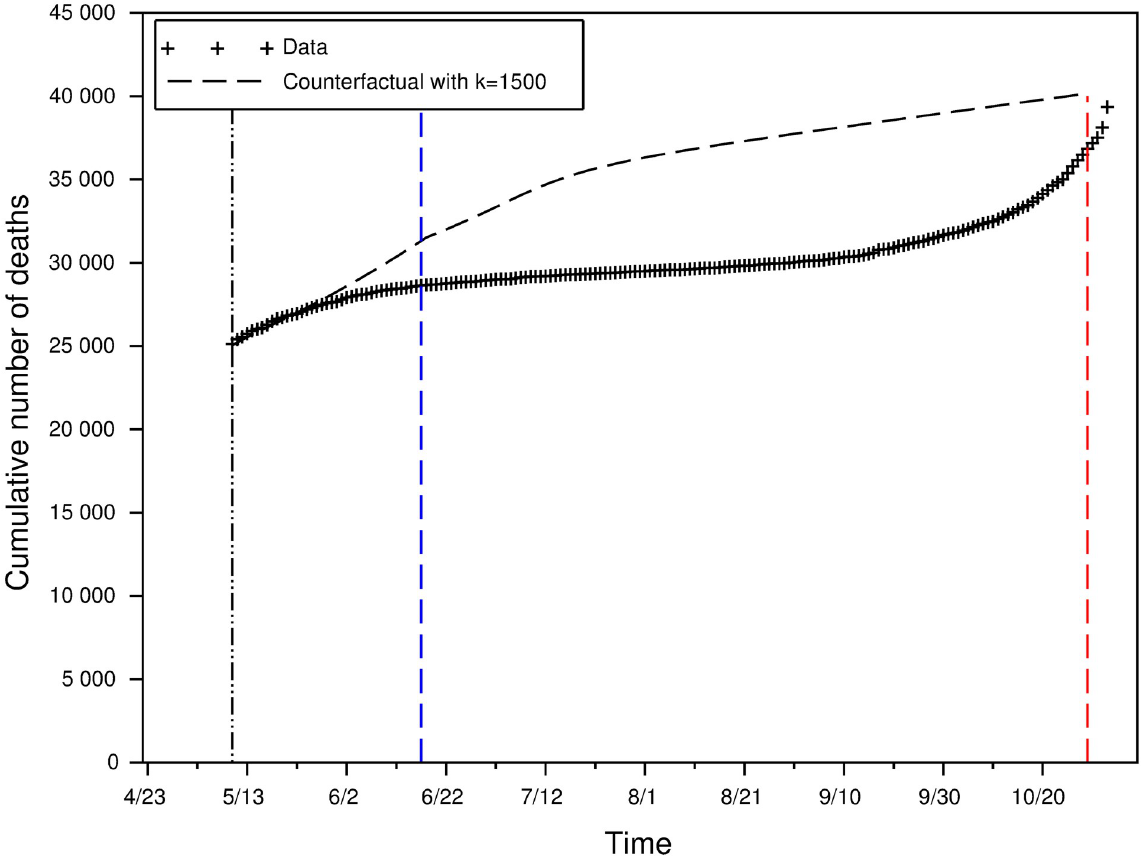
Fig 9. Cumulative number of deaths during intermediate lockdown (data) vs in the equilibrium